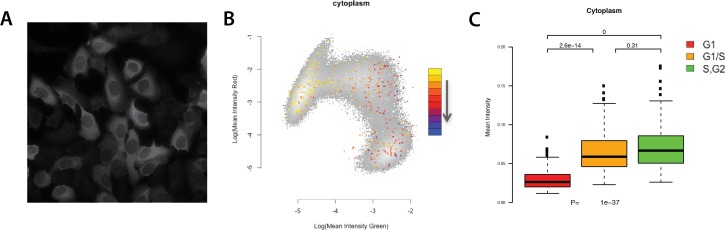
RRM2 is cell cycle regulated in U2OS cells, showing peak abundance in G2 phase.(A) A representative image of FUCCI U2OS cells immunostained for RRM2. (B) A psuedocolour scatter plot with x- and y- axes representing the two proteins used in the FUCCI cell cycle reporter system (Red: Cdt1, Green: Geminin) with colour indicating anti-RRM2 signal. (C) Bar chart summarising (B).